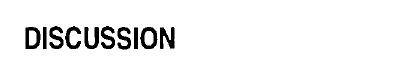
Intervertebral joint